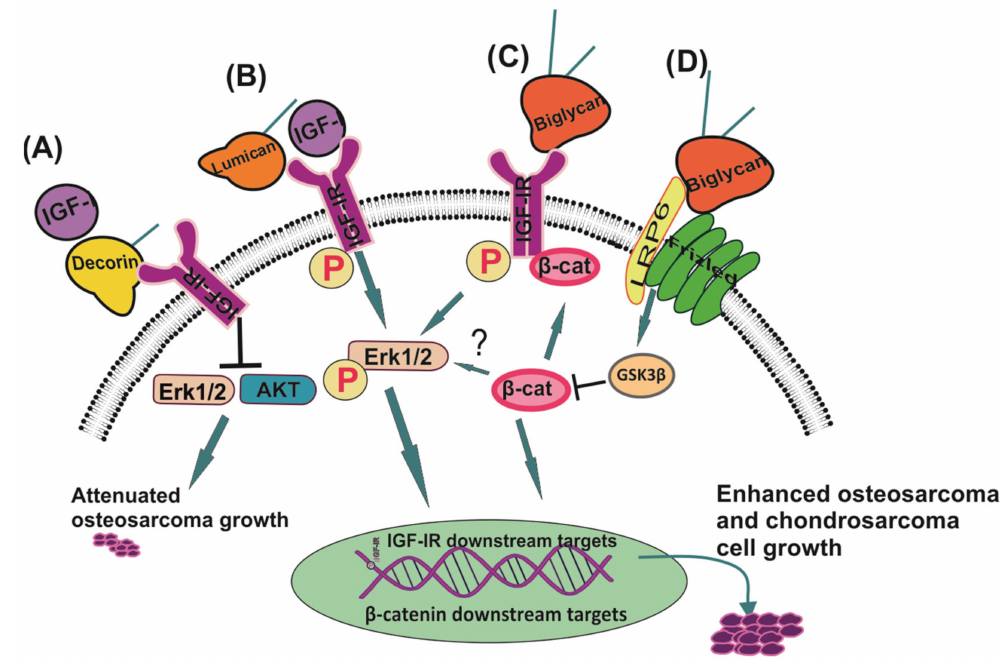
Figure 1. The role of SLRPs on IGF/IGF-IR-dependent cell growth. ( A ) Decorin attenuates ligand-dependent IGF-IR activation and inhibits IGF-IR-restricted Erk1/2 and AKT signaling correlated with decreased osteosarcoma oncogenic potential. ( B ) Lumican forms a complex with IGF-IR to stimulate basal and IGF-1-induced chondrosarcoma cell growth in an ERK-dependent manner. ( C ) Biglycan co-localizes with IGF-IR to enhance its basal and IGF-1-dependent activation and correlated osteosarcoma cell growth. ( D ) Biglycan binds to LRP6/frizled complex initiating a convergence of β -catenin/IGF- IR signaling facilitating osteosarcoma cell growth.